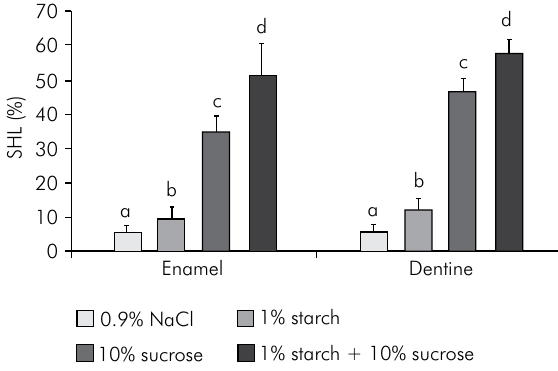
Figure 3. Percentage of surface hardness loss (%SHL) in enamel and dentine slabs according to the treatments administered to the biofilms (mean ± SD, n = 9). Different letters indicate significant differences (p < 0.0001) among treatments (within the dental substrates). For statistical analysis, %SHL for enamel was transformed using the square